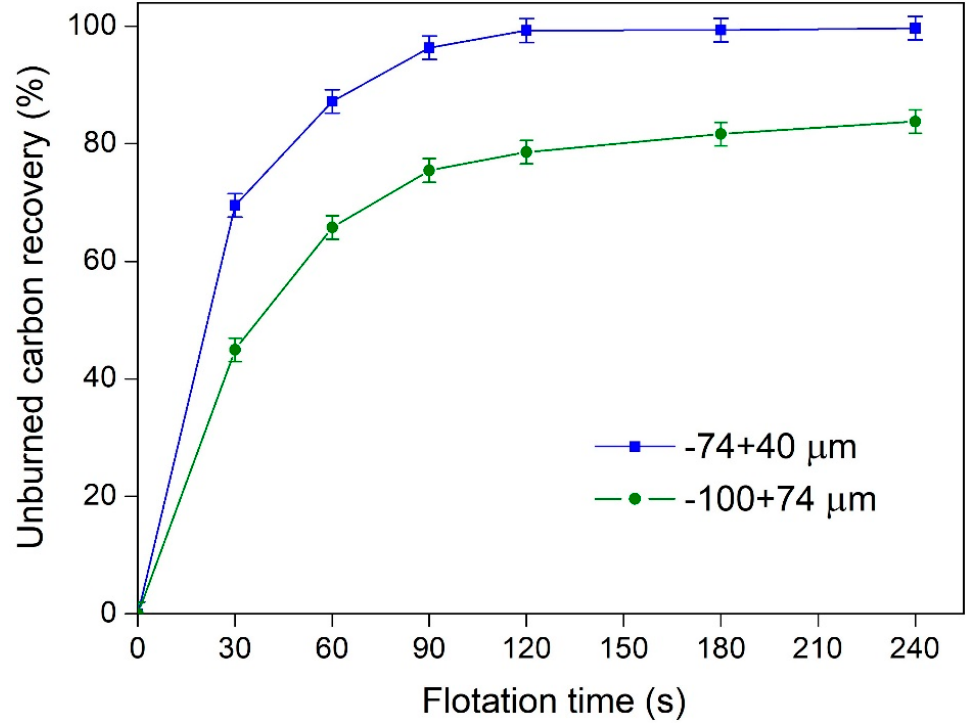
Figure 9. The effect of particle size and flotation time on the unburned carbon recovery. Figure 9. The e ff ect of particle size and flotation time on the unburned carbon